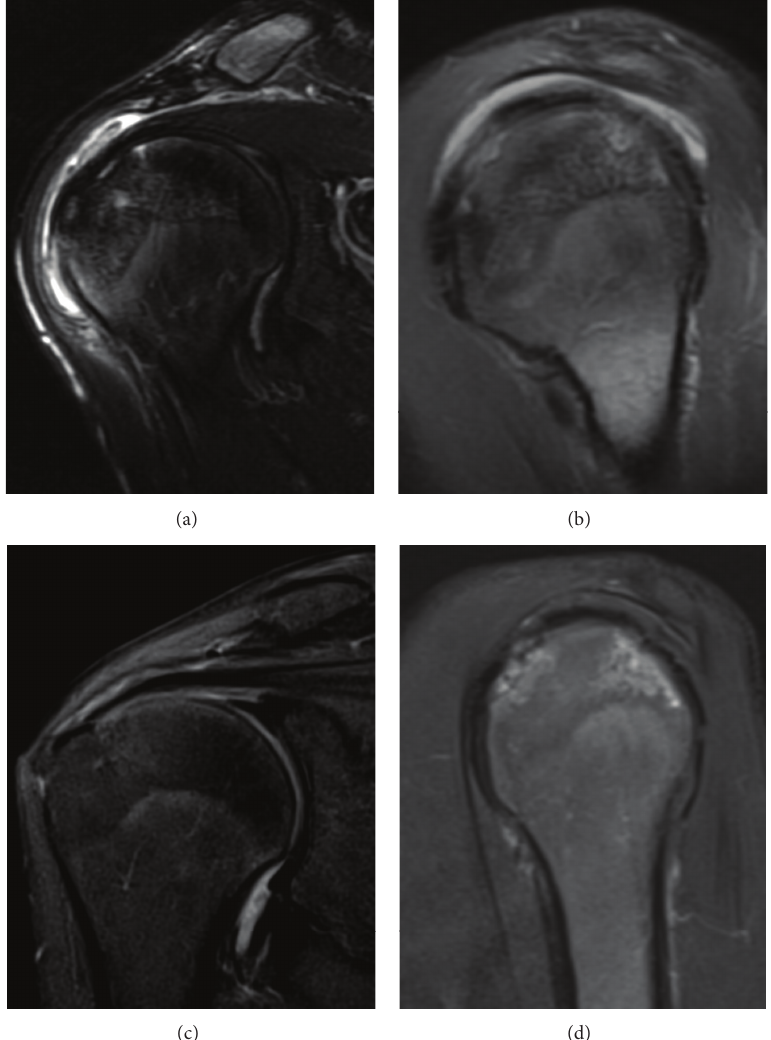
Figure 2: Coronal fat-suppressed T2 weighted (a) and sagittal fat-suppressed proton density weighted (b) sequences demonstrate synovial effusion and pannus in the glenohumeral joint and subdeltoid bursa. Cortical erosions of humeral head are revealed. In the follow-up MR imaging after treatment, coronal fat-suppressed T2 weighted (c) and sagittal fat-suppressed proton density weighted (d) sequences, depict resolution of synovial effusion and pannus. Cortical erosions are still